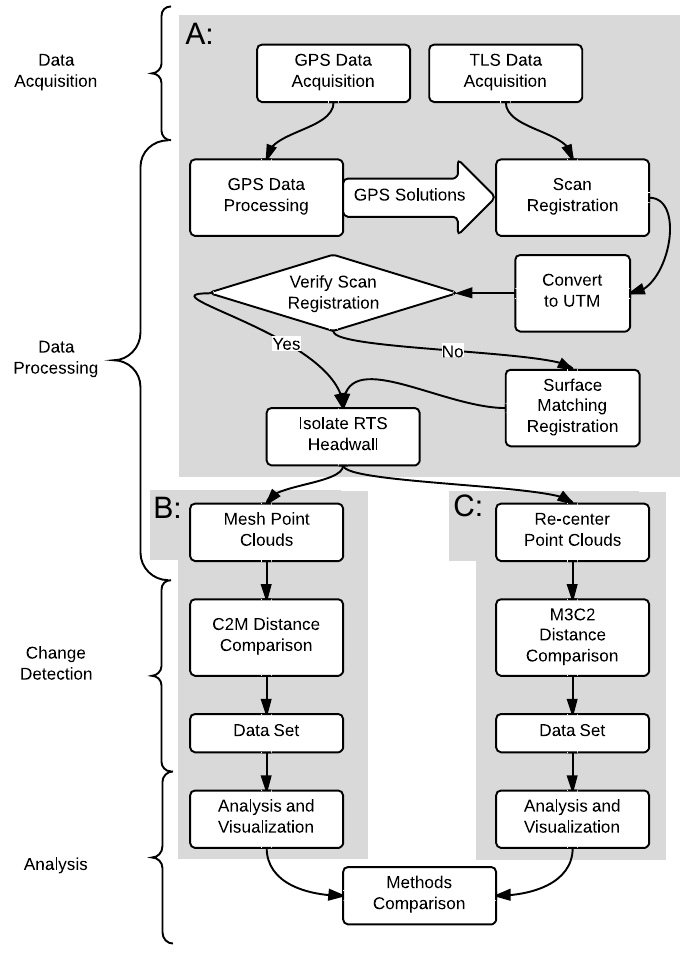
Figure 2. Flow chart of terrestrial laser scanners (TLS) and GPS data acquisition, processing, analysis and comparison. Workflows for both C2M and M3C2 are identical ( A ) until the process branches for the C2M ( B ) and M3C2 ( C )